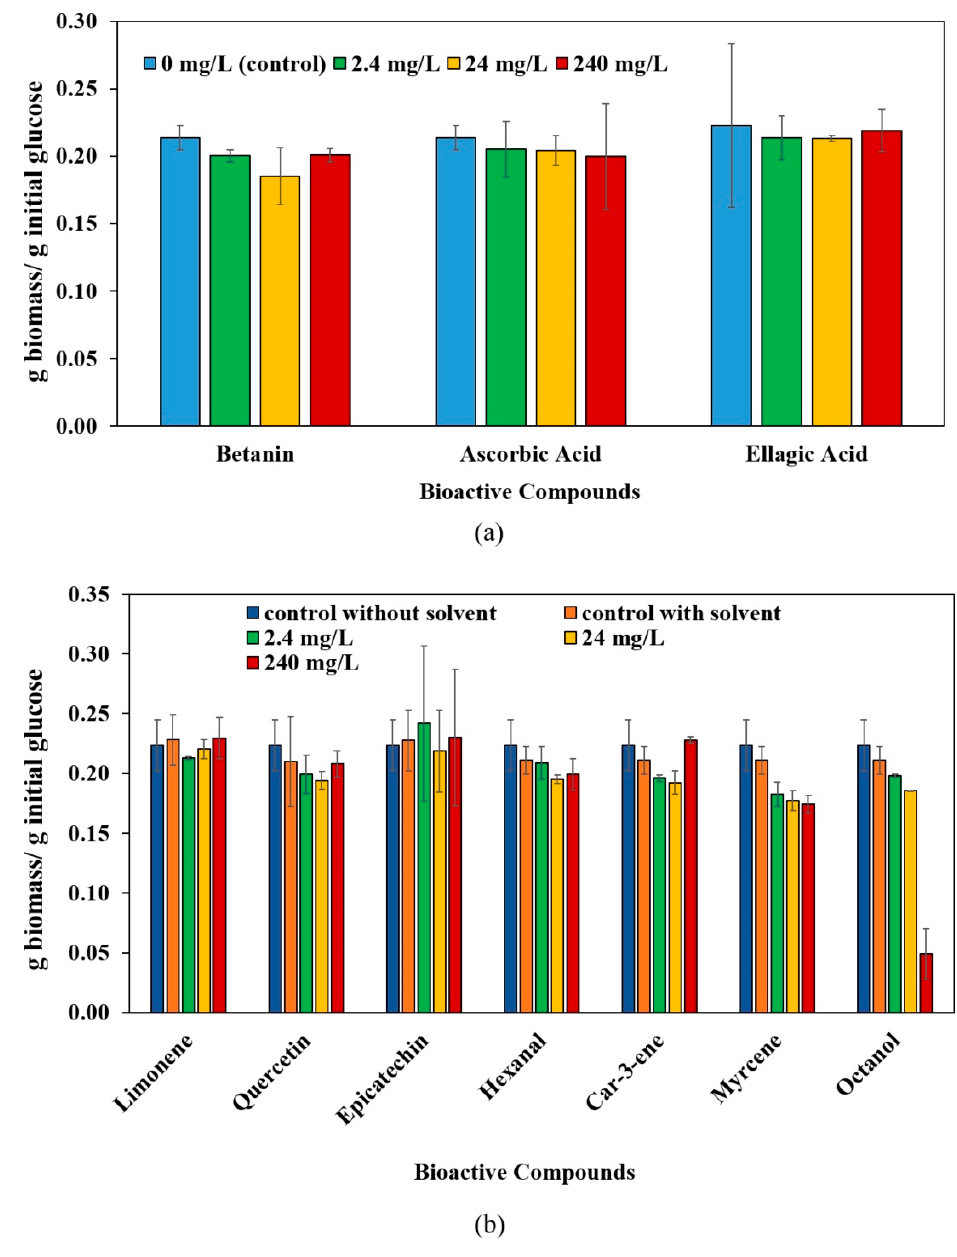
Figure 1. The effect of FPW bioactive compounds on biomass yield of A. oryzae . ( a ) The compounds that had water as solvent (ellagic acid had NaOH solution as a solvent; however, since the initial pH of the medium was at the required pH of cultivation, the control condition was the same as betanin and ascorbic acid). ( b ) The compounds that had a solvent other than water had two control (one control without bioactive compound and solvent and another control with solvent without bioactive compounds).